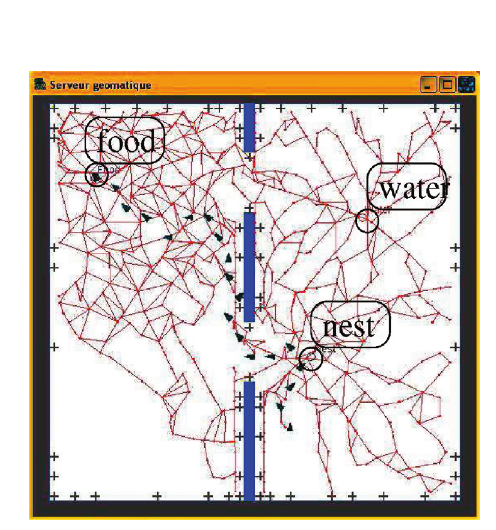
Figure 8. Cognitive map build by exploration of a simulated environment with two rooms linked by two doors. The triangles give the successive robot position starting on the right until the goal on the